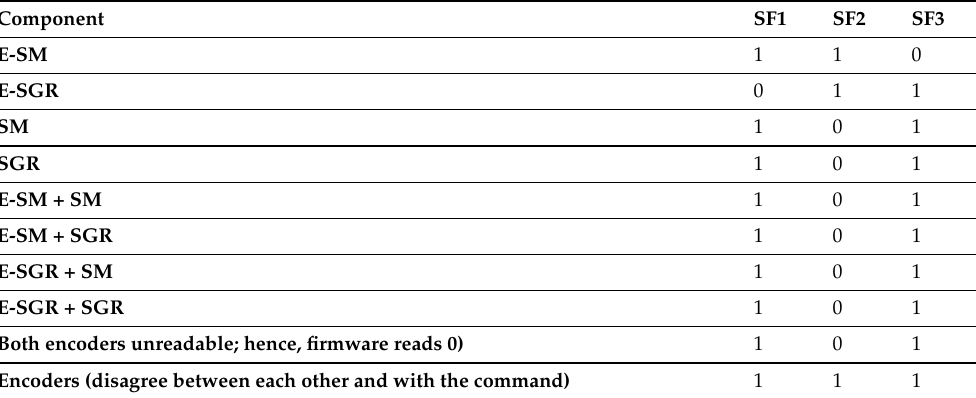
Table 6. Flag-failure associations for the steering subsystem